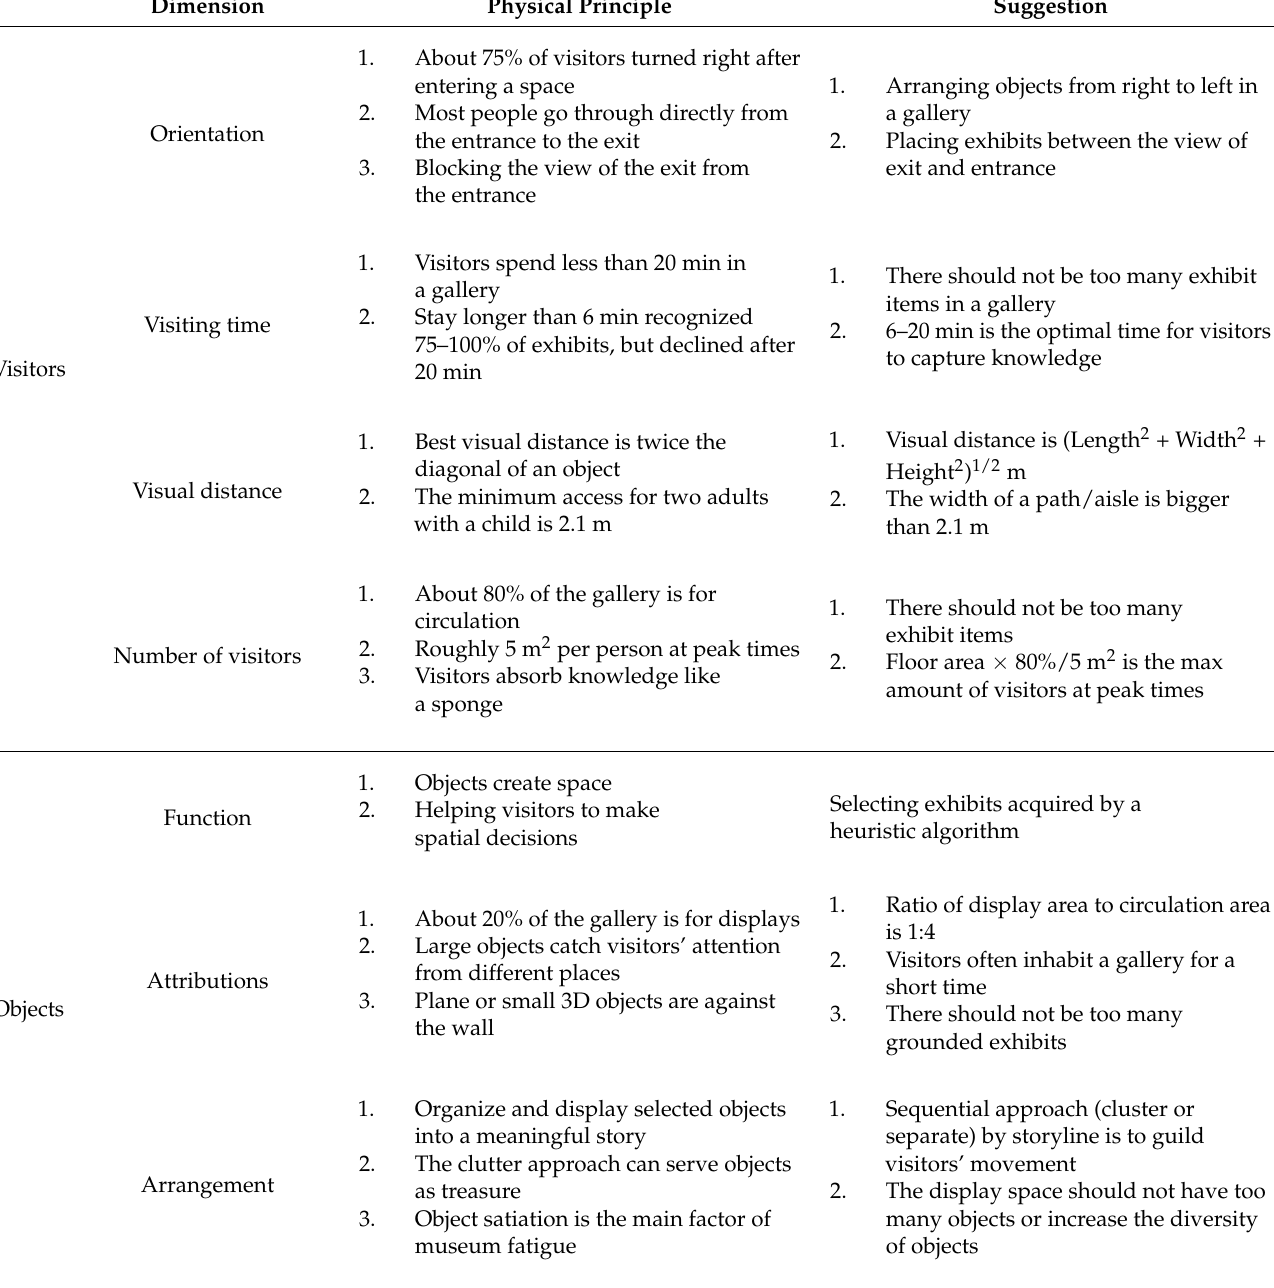
Table 4. The abstract of the physical principles and suggestions for exhibit layout planning